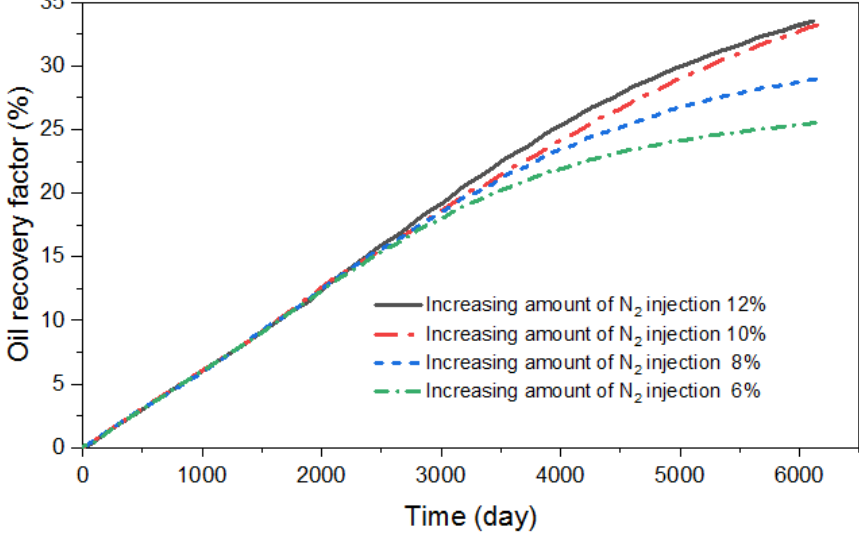
Figure 17. The comparison of oil recoveries under increasing volumes of N 2